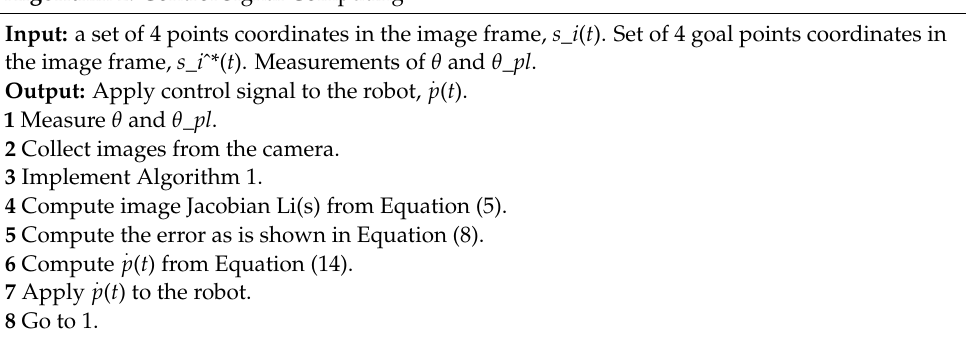
Algorithm 2: Control Signal Computing